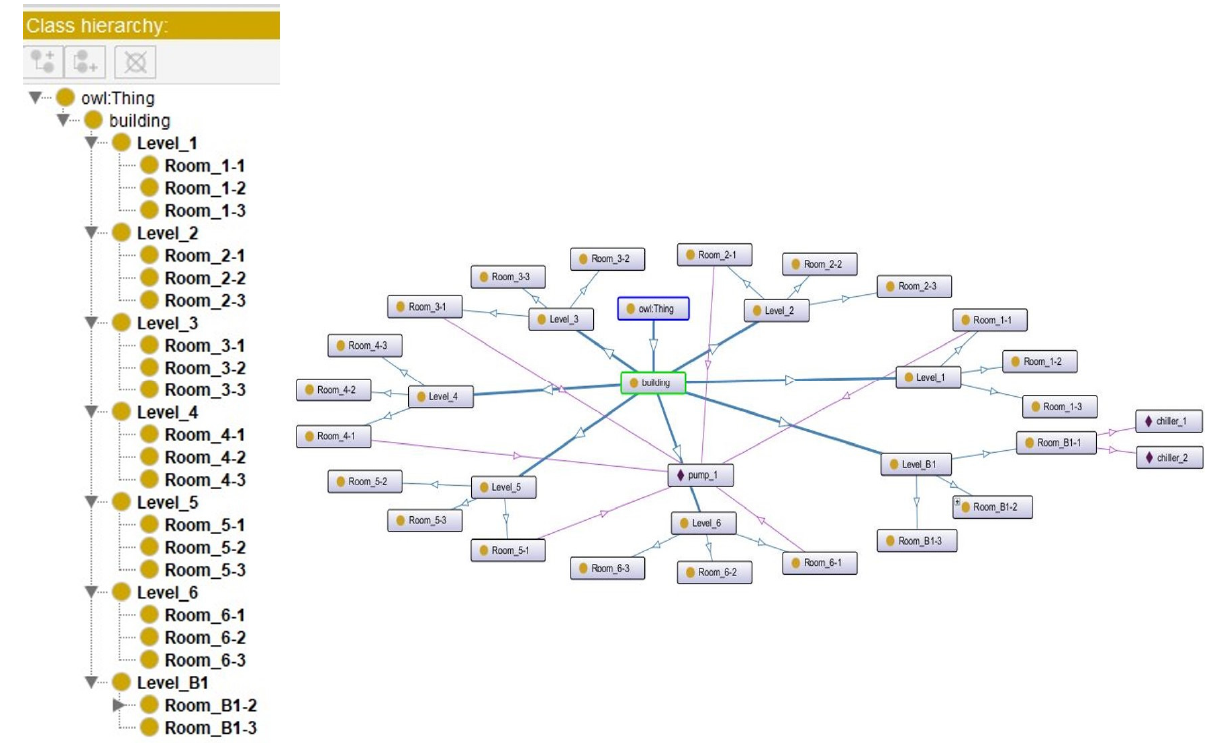
Figure 9. The ontology framework of the target building.